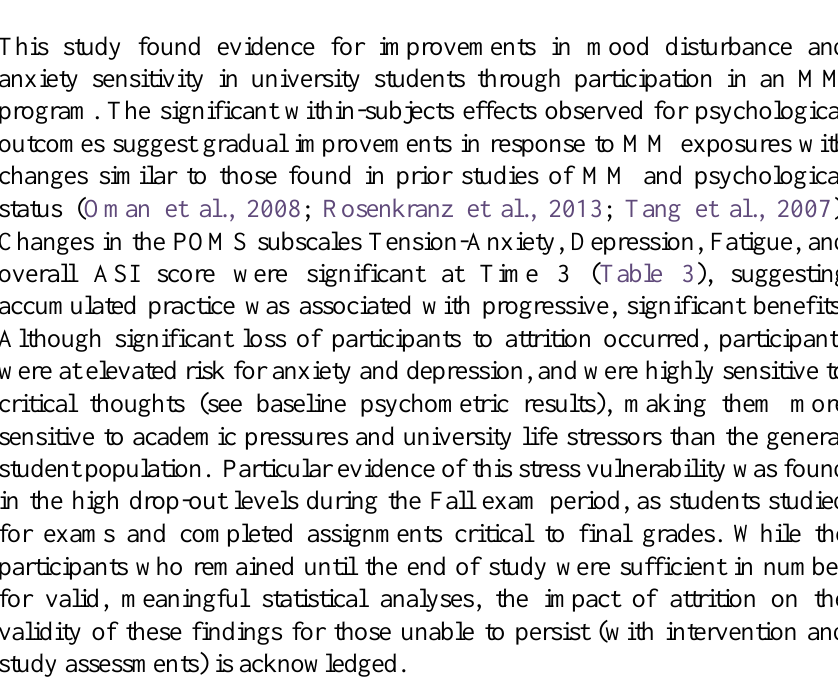
Table 4 lists results of the regression model tested, using POMS Depression ∆ at Time 2 as outcome and SC as primary predictor, with age and the Dependency subscale score as covariates. Dependency was included based on prior research strongly linking it with Self-Criticism (Mongrain & Leather, 2006). The model was significant overall (p < 0.05), and SC was found inversely related to reductions in depressed mood (i.e., higher Self- Criticism predicted greater reductions in Depressed Mood) at Time 2, accounting for 35% of variance (p < 0.05). It was noted that the sample (N = 37) and the analysis of 3 variables satisfied Cohen criteria of at least 10 subjects per variable (Cohen, 1988). However, the model achieved only modest observed (post-hoc) power of 58 percent (at the < 0.05 level) to detect a significant